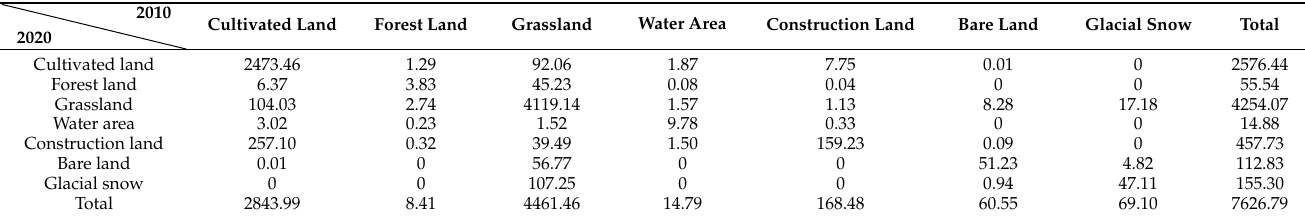
Table 7. The land use transfer matrix in Xining from 2010 to 2020 (unit: km 2 ).